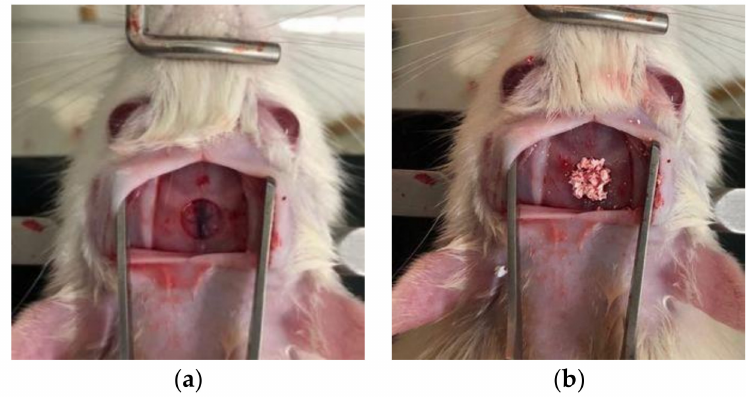
Figure 2. Calvarial defect in rats. ( a ) The appearance of calvarial defect used trephine bur, ( b ) Bone graft applied to calvarial defect.